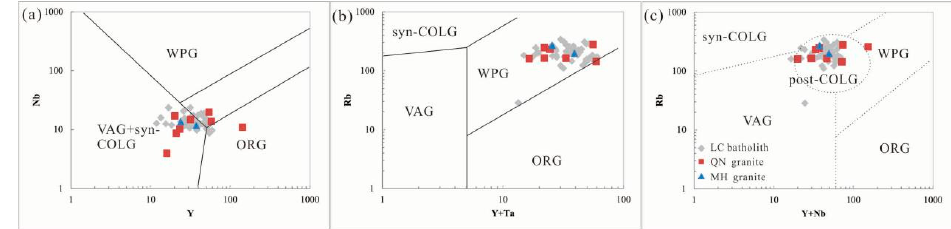
Fig.11 Geochemical discrimination diagrams of the Lincang granite Figure 11. Plots of Y versus Nb ( a ), Y + Ta versus Rb ( b ) and Y + Nb versus Rb ( a ) for the LC granite (modified from references